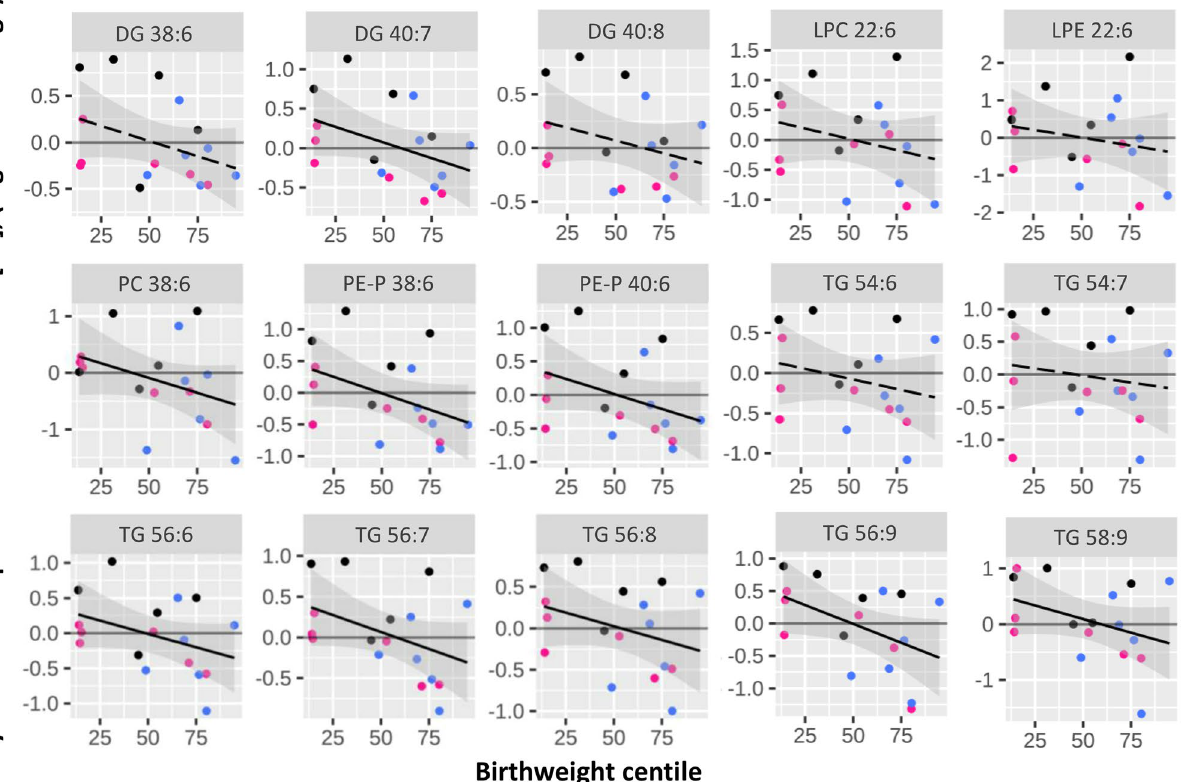
Figure 4. The association of myo-inositol response with birthweight centile. Linear regression was run with birthweight centile as the outcome and myo-inositol response as the predictor variable. Myo-inositol response (log2-fold-change) represents the relative amount of 13 C-DHA lipid in placental explants treated with myo- inositol (60 µmol/L) compared with control explants from the same placenta not treated with myo-inositol. Birthweight centile was standardized for sex and gestational age using local references 65,66 . The Benjamini- Hochberg (BH) method was used to correct for multiple testing. Solid lines show statistically significant associations while dashed lines show non-significant trends. Shaded areas show 95% confidence intervals. Black: Normal BMI (< 23 kg/m 2 ), Blue: overweight (BMI 23 to < 27.5 kg/m 2 ), Pink: obese (BMI ≥ 27.5 kg/m 2